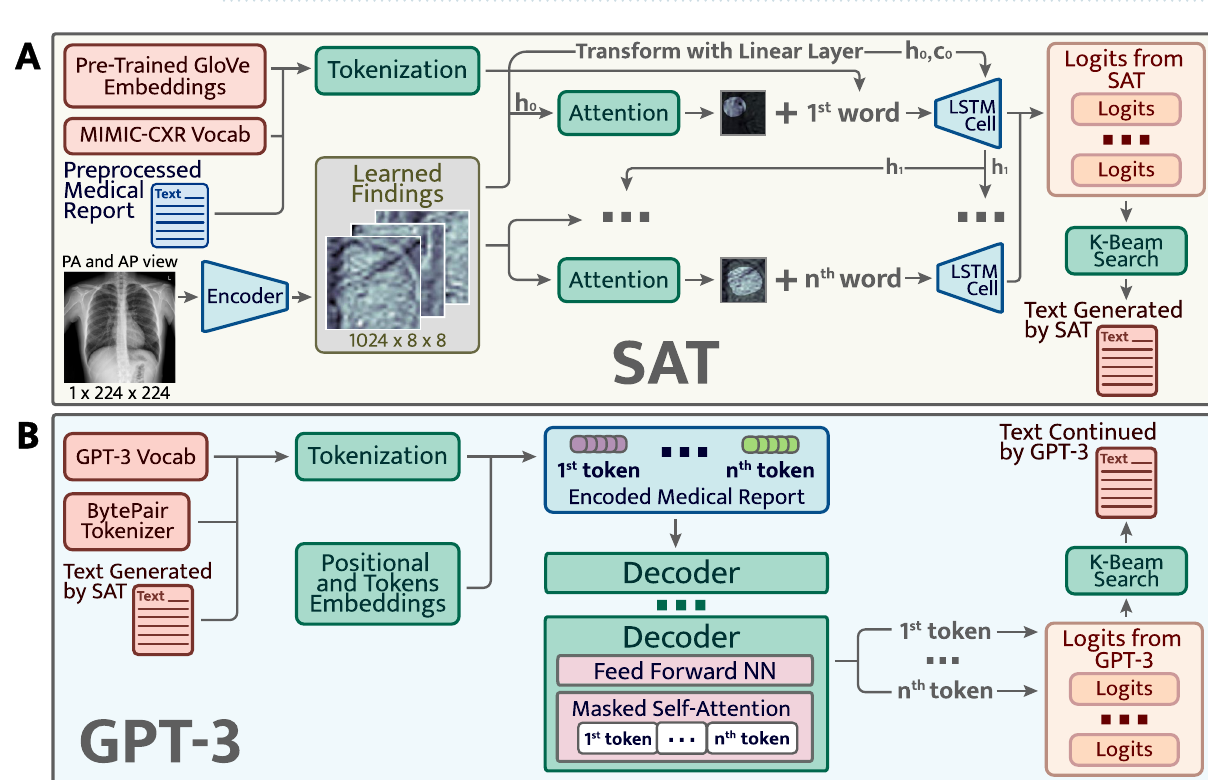
Figure 3. The second approach. Pretrained GPT-3 ( B ) continues text generated by SAT ( A